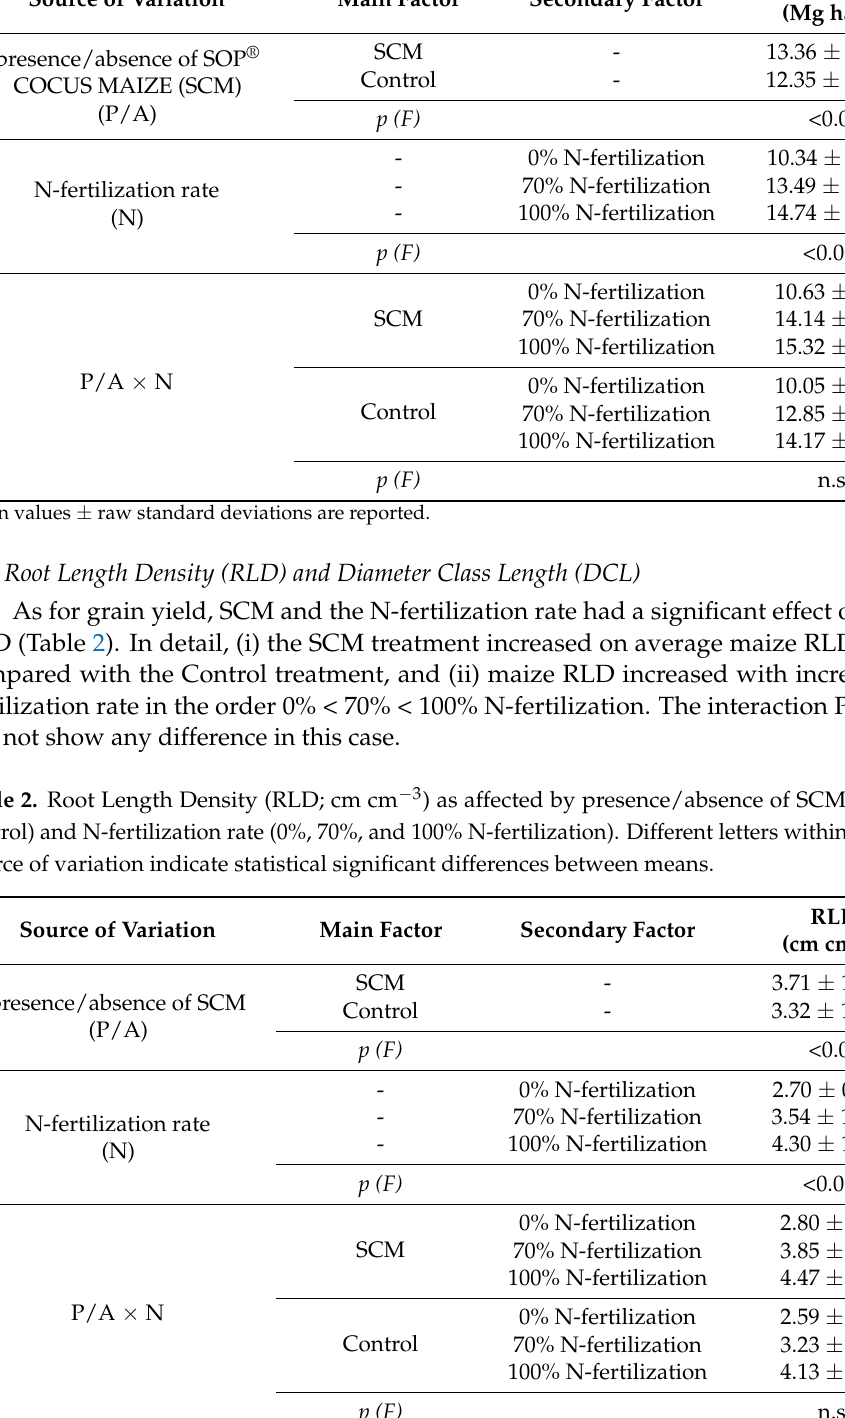
Mean values ± raw standard deviations are